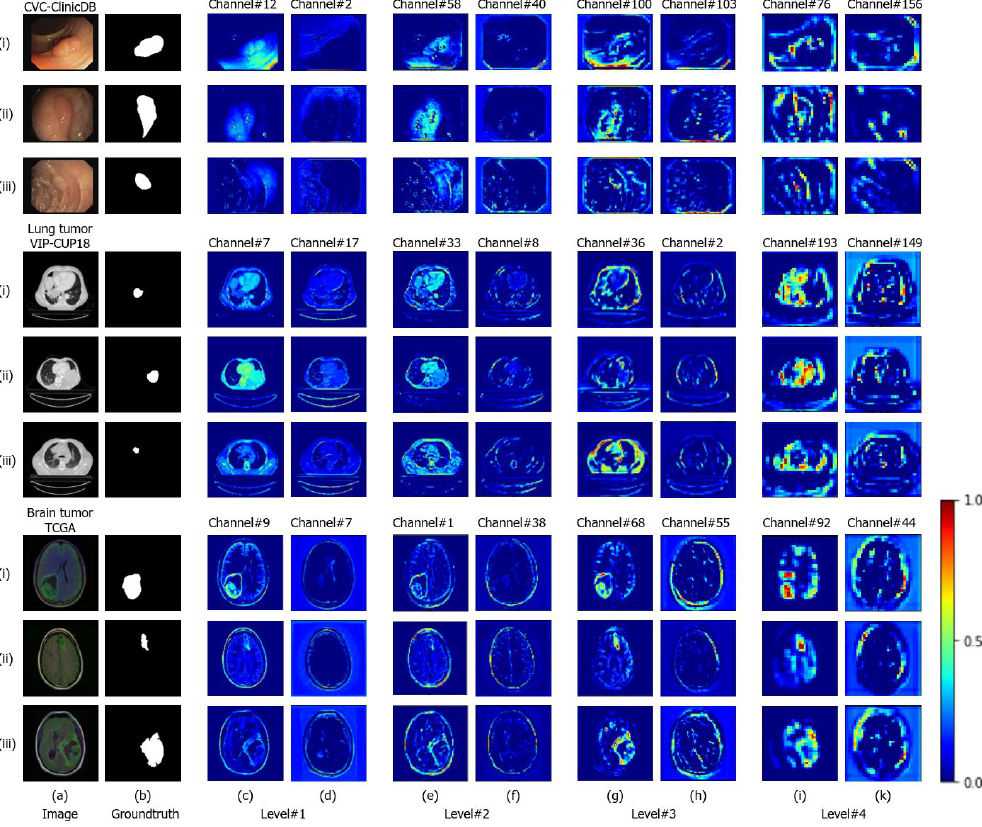
Figure 8. Channel feature map emphasized by the Channel Attention Gate